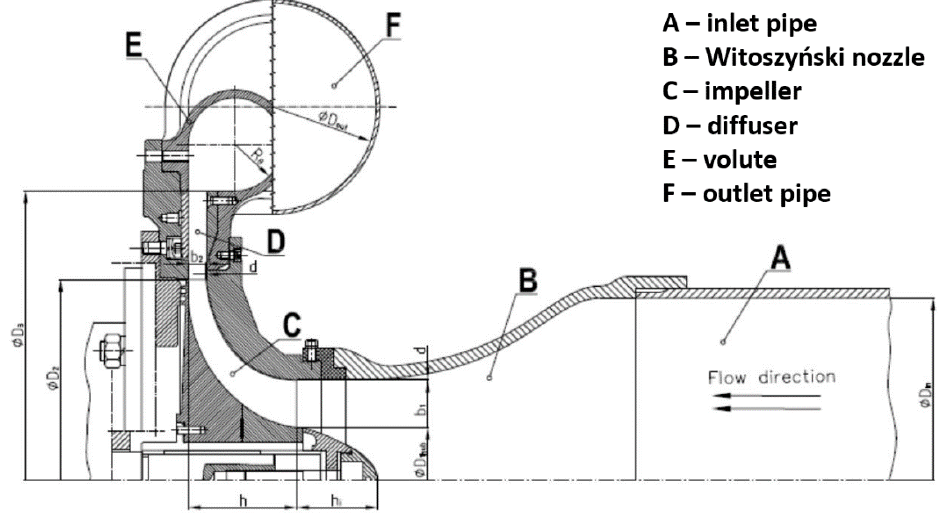
Figure 1. Cross-section of DP1.12 blower.